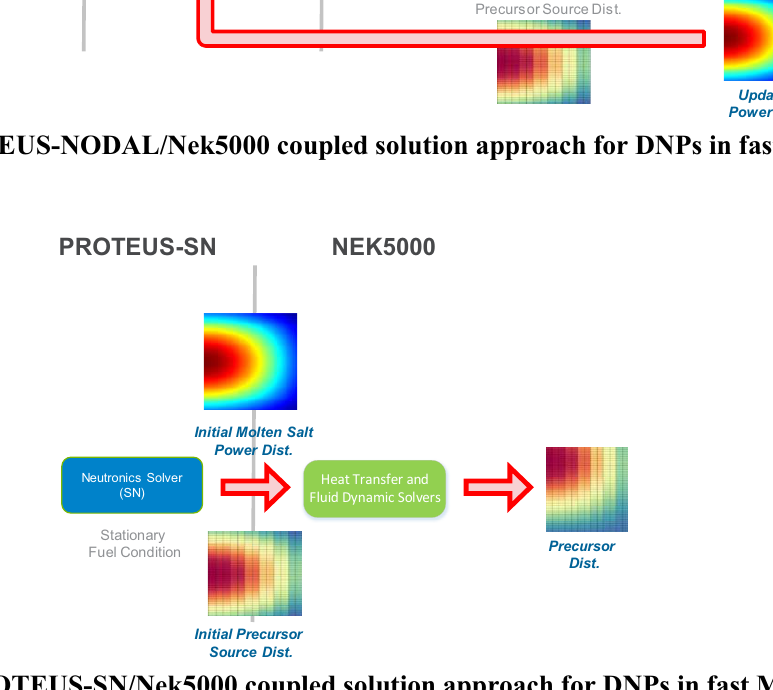
Figure 2. PROTEUS-SN/Nek5000 coupled solution approach for DNPs in fast